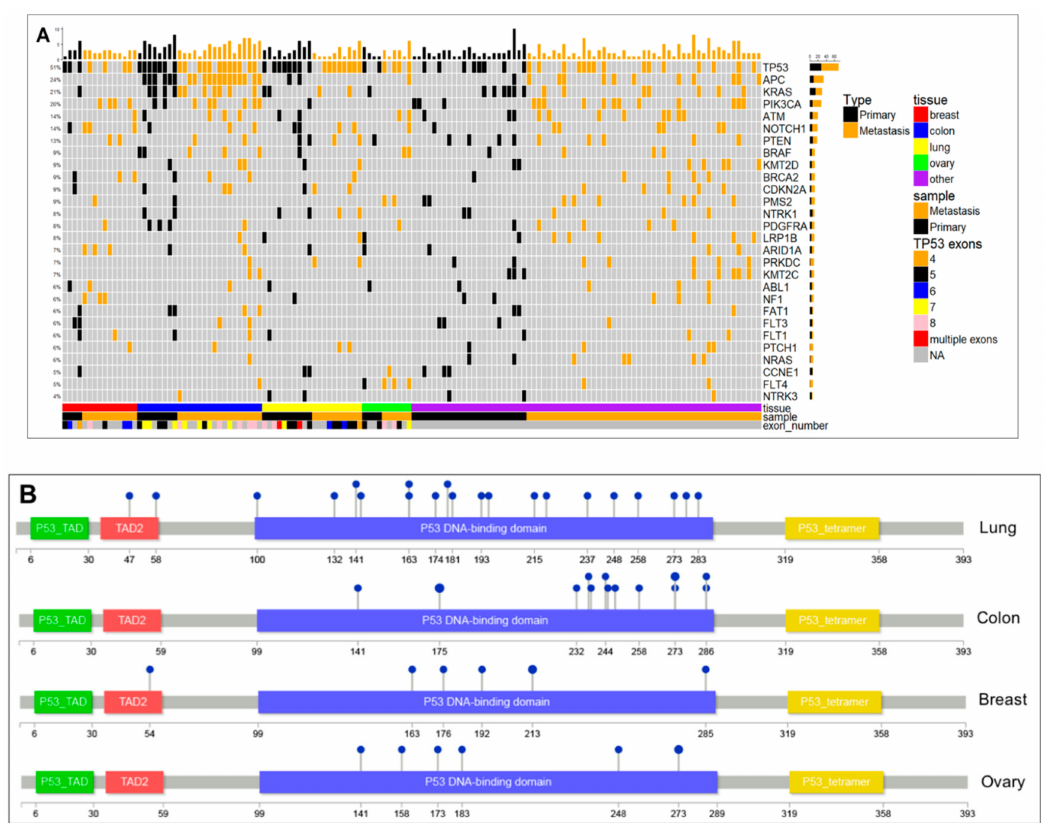
Figure 5. ( A ) Mutational profile of all patients from all tumor types. The figure shows frequency of mutations and differences in primary and metastatic tissue for different tumor types. ( B ) Schematic diagram of TP53 gene and its site-specific mutations in lung, colon, breast, and ovarian tumor